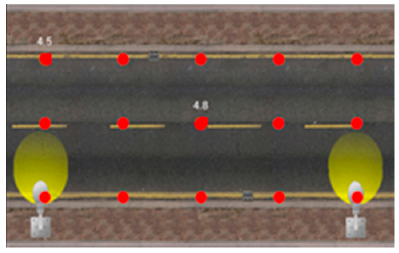
Figure 1. Illuminance measurement.